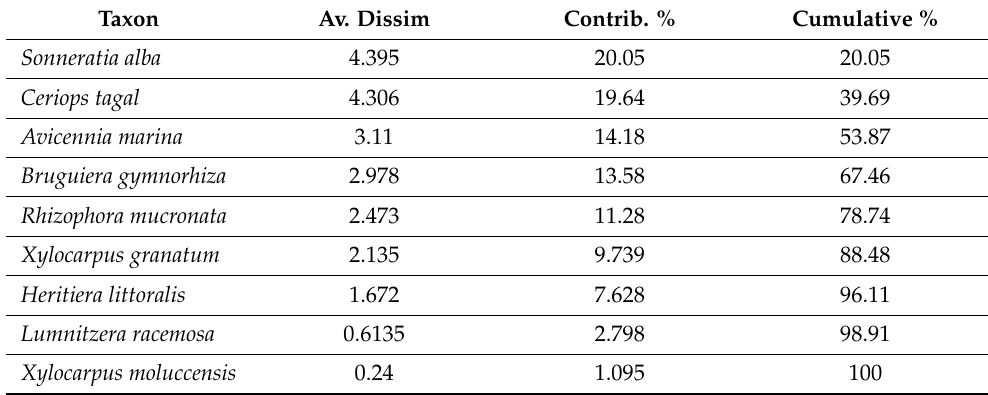
Table 2. Average dissimilarities and species contributions to dissimilarity across the 14 sites along the coastline of Kenya as assessed with SIMPER.